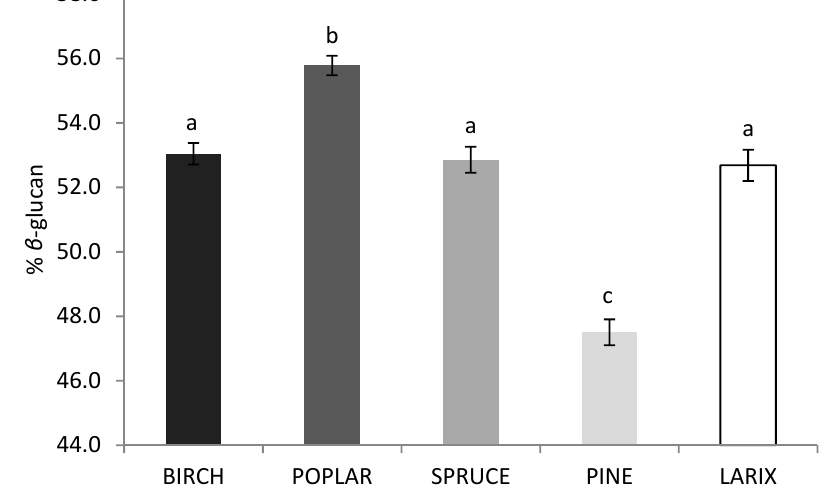
Figure 4. Effect of the wood substrate on the β -glucan content of G. lucidum fruiting bodies estimated in Equation (3). Significant differences ( p < 0.05) between the square root yields are represented with different letters (a, b and c).